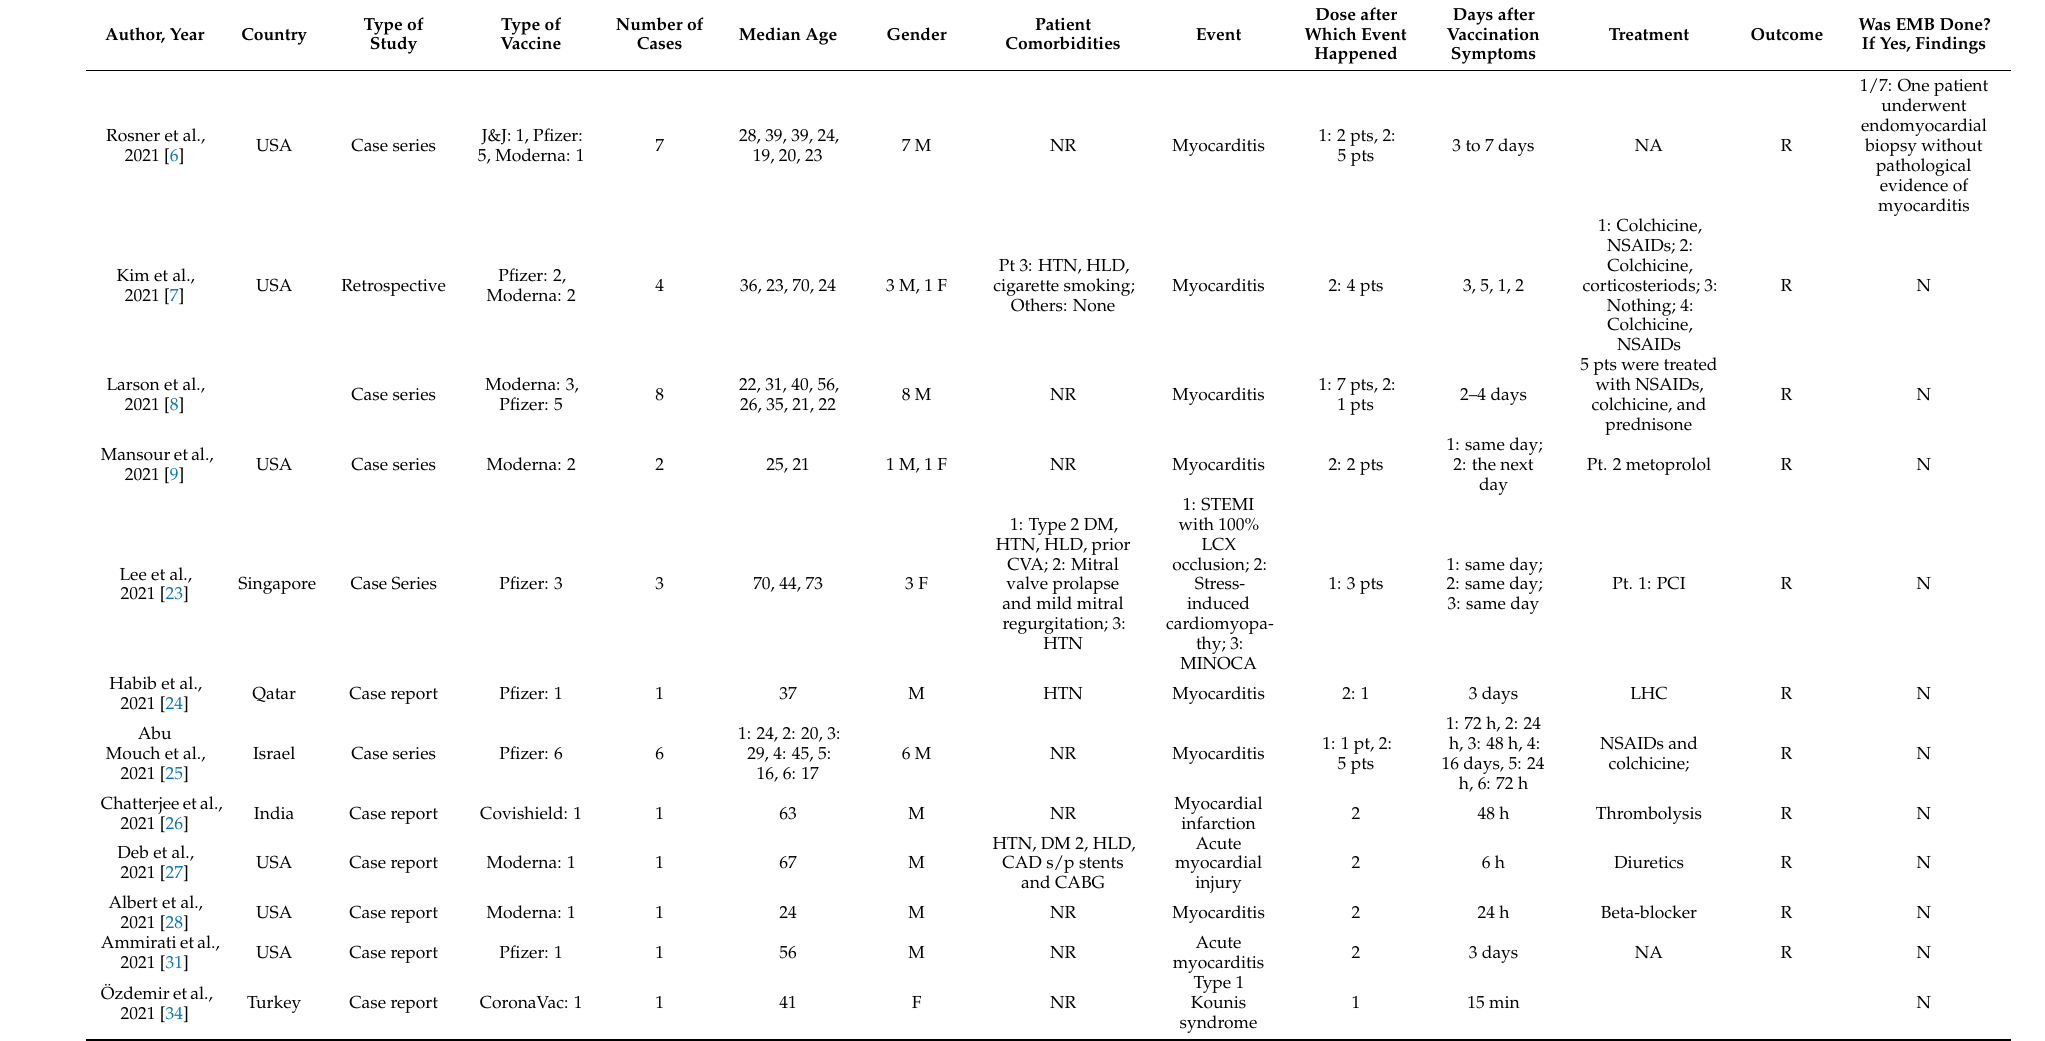
Table 3. Adverse events after COVID-19